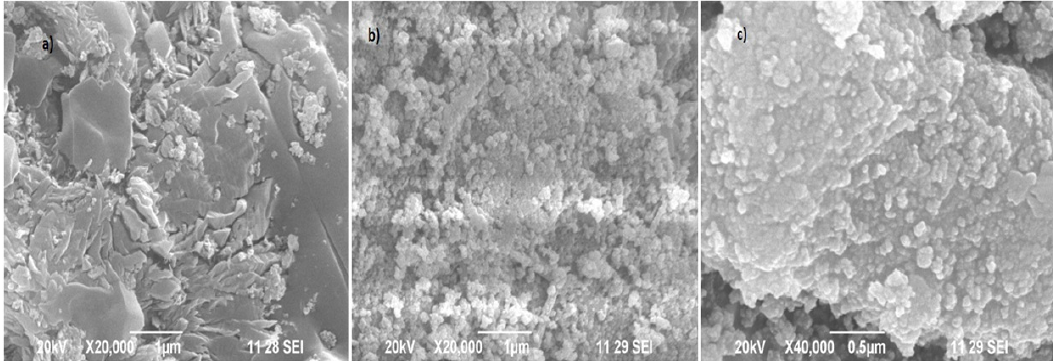
Fig. 4.(a) SEM image of ZrO